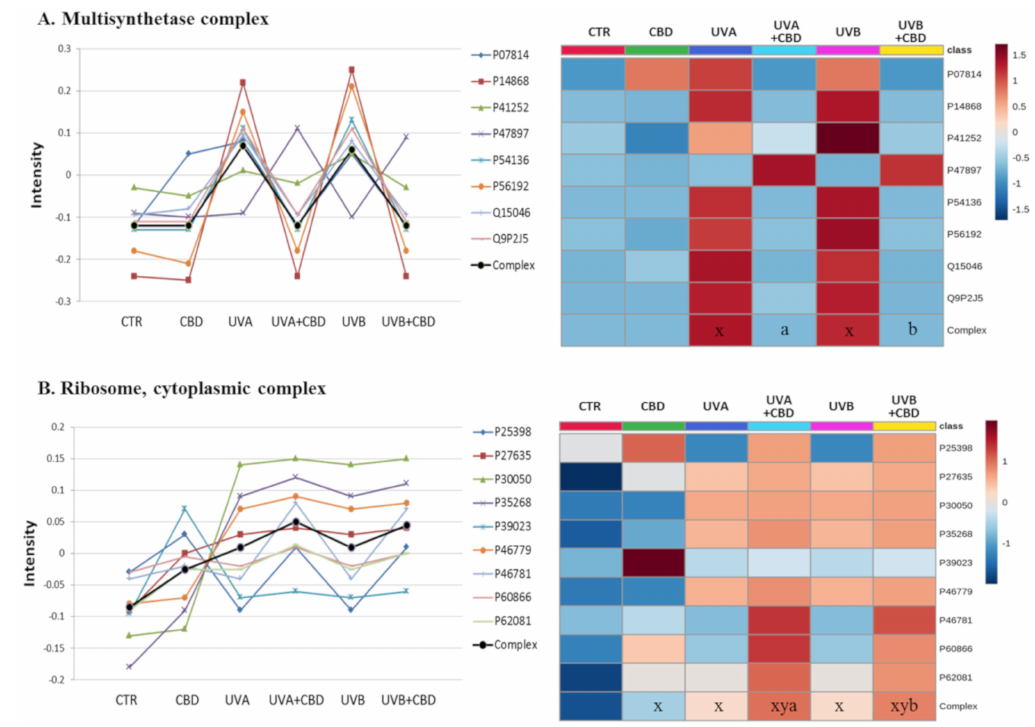
Figure 5. The point graph and heatmap showing the average intensity of proteins creating multisynthetase ( A ) and ribosome ( B ) complexes in keratinocytes following UVA (30 J/cm 2 ) or UVB (60 mJ/cm 2 ) radiation and treated with cannabidiol (CBD, 4 µ M) in a three-dimensional culture model. Proteins IDs: P07814, glutamate/proline-tRNA ligase; P14868, aspartate-tRNA ligase; P41252, isoleucine-tRNA ligase; P47897, glutamine-tRNA ligase; P54136, arginine-tRNA ligase; P56192, methionine- tRNA ligase; Q15046, lysine-tRNA ligase; Q9P2J5, leucine-tRNA ligase; P62081, P46781, P25398, P60866, 40S ribosomal proteins S7, S9, S12, S20; P39023, P27635, P30050, P35268, P46779, 60S ribosomal protein L3, L10, L12, L22, L28. Statistical significances showed only for the whole complexes. x: statistically significant differences vs. non-treated cells, p < 0.05; y: statistically significant differences vs. CBD-treated cells, p < 0.05; a: statistically significant differences vs. UVA-irradiated cells, p < 0.05; b: statistically significant differences vs. UVB-irradiated cells, p < 0.05.